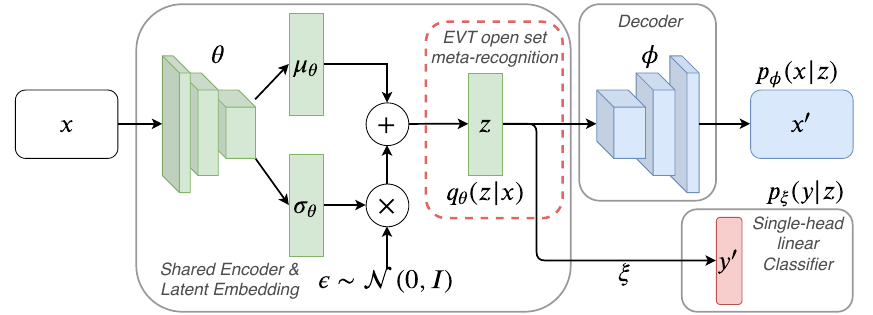
Figure 1. A joint continual-learning model consisting of a shared probabilistic encoder q θ ( z | x ) , probabilistic decoder p φ ( x , z ) and probabilistic classifier p ξ ( y , z ) . For open-set recognition and generative replay with outlier rejection, extreme-value theory (EVT) based bounds on the basis of the approximate posterior are